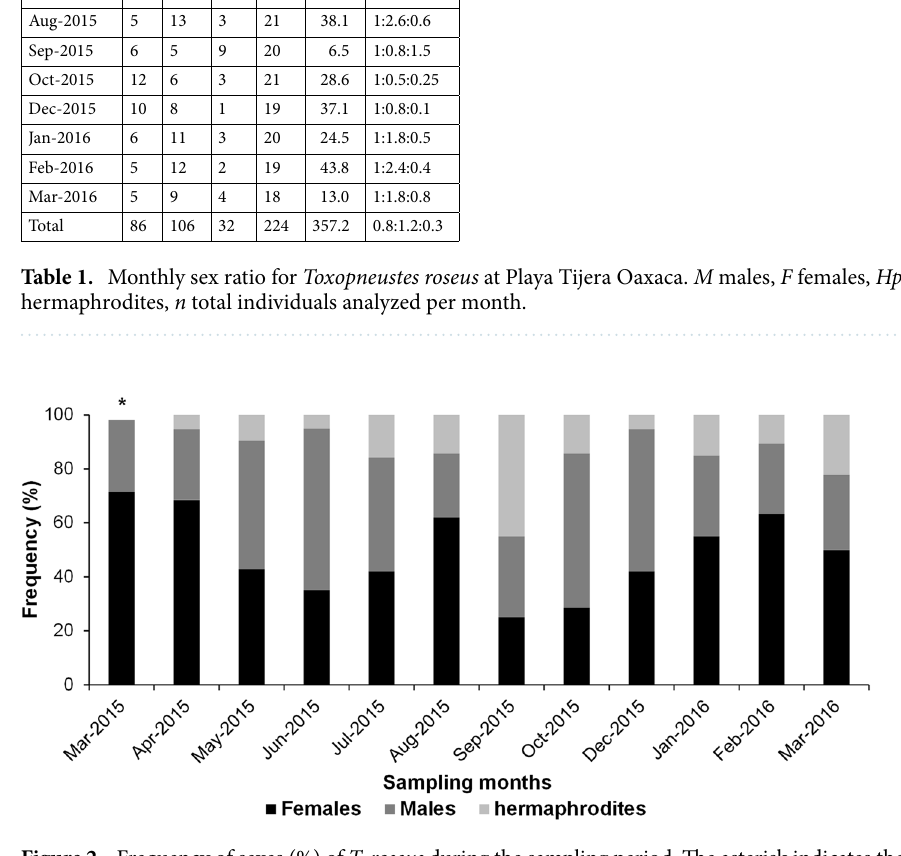
Figure 2. Frequency of sexes (%) of T. roseus during the sampling period. The asterisk indicates the month in which hermaphroditic individuals were not